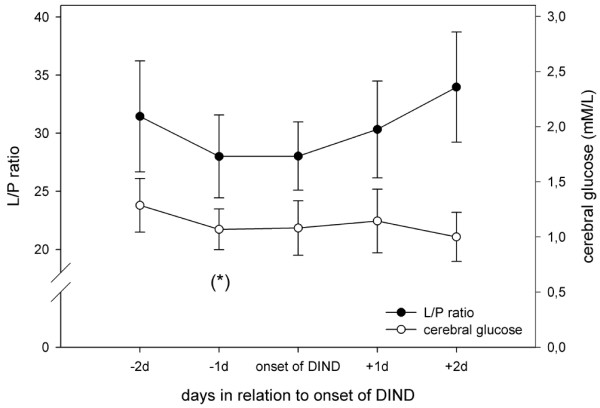
Course of cerebral extracellular glucose and lactate/pyruvate ratio in insulin-treated SAH patients developing DIND. Data are expressed as mean ± standard error of daily medians calculated from hourly measured microdialysate levels of glucose and lactate:pyruvate (L/P) ratio in nine insulin-treated subarachnoid haemorrhage (SAH) patients developing delayed ischaemic neurological deficit (DIND). (*) indicates a trend (P < 0.1) toward a decrease in cerebral glucose, comparing the levels at 2 days and 1 day before onset of DIND (Wilcoxon signed-rank test, P = 0.068).